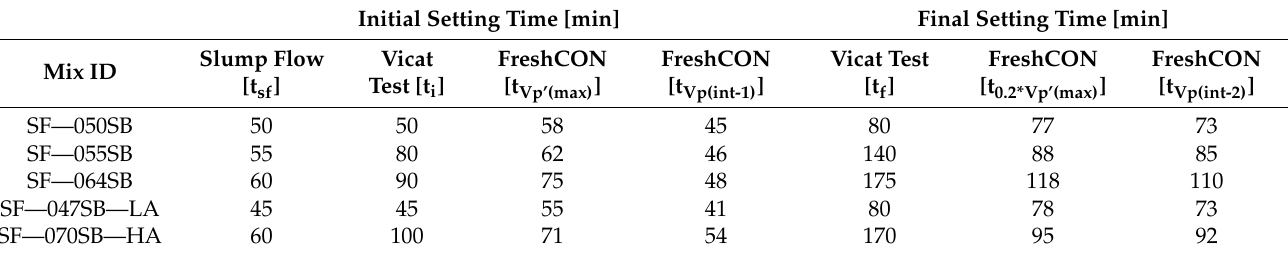
Figure 8. Different stages, intersections, and inflection points on the UPV curve as a function of age. Table 6. Initial and final setting times obtained from different techniques.